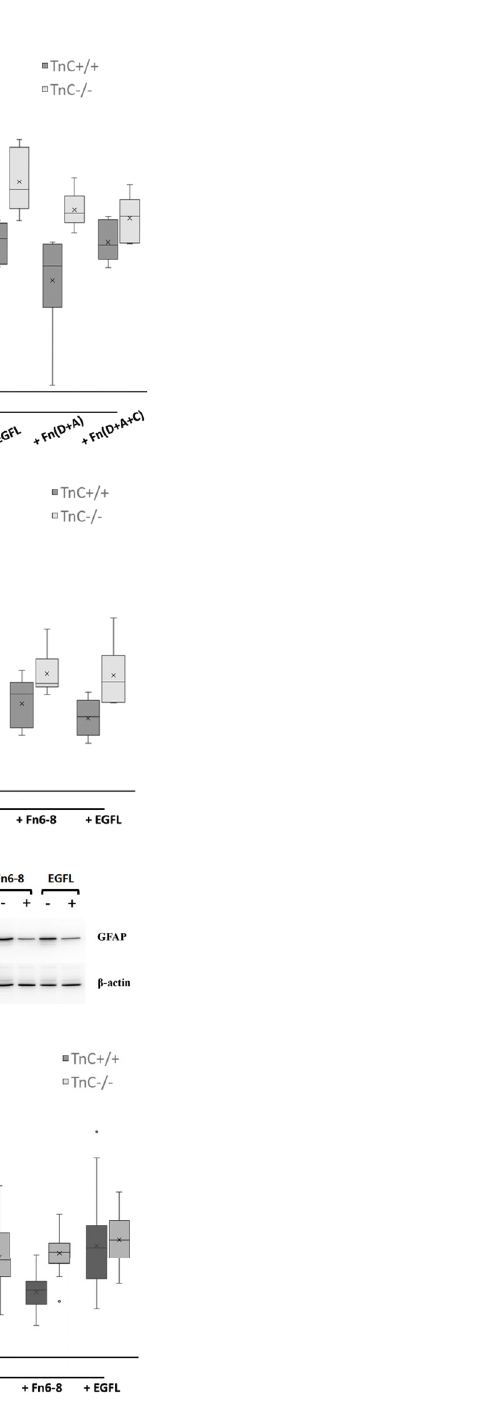
FIGURE 3 | GFAP expression is upregulated in TnC-/- astrocyte cultures both in the absence and presence of fragments. (A) Relative log 2 -fold change of Gfap mRNA expression 6 h after scratching and fragment addition is shown in a box-and-whisker plot. Two-way ANOVA shows a genotype effect ( p < 0.001). Gfap mRNA was signi fi cantly upregulated in TnC-/- no SW group compared to its TnC+/+ counterpart ( p = 0.041). n = 4 independent astrocyte culture preparations. (B) Relative GFAP protein expression as estimated by Western blot analysis 24 h after scratching and application of fragments. Results are presented as box-and- whisker plot. Two-way ANOVA shows statistical signi fi cance of genotype ( p < 0.001). GFAP is more expressed in the no SW group of TnC-/- versus TnC+/+ cultures ( p < 0.001). Scratching alone and FnA, FnC, and FnD application lead to upregulation of GFAP protein levels in TnC-/- versus TnC+/+ astrocytes ( p < 0.001; p = 0.003; p = 0.002: p = 0.001, respectively). n = 3 independent astrocyte culture preparations. (C) Representative images of Western blots for GFAP (48 kDa) and b ‐ actin (42 kDa). (D) GFAP immunoreactivity is presented as Integrated density box-and-whisker plot. n = 1 astrocyte